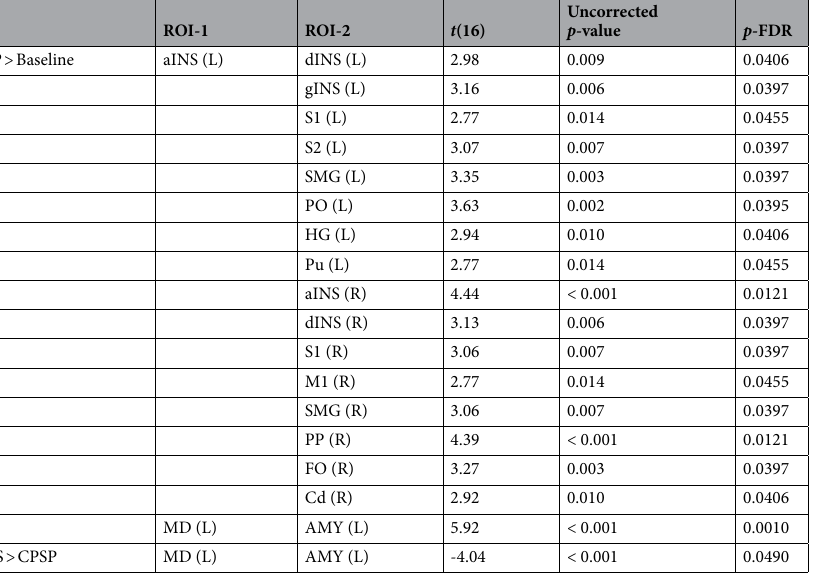
Table 1. The statistical values in ROI-to-ROI analysis. The p -values and t -values of the functional connectivity that significantly changed in the ROI-to-ROI analysis. The significance level was the ROI-level adjusted for multiplicity ( p -FDR < 0.05). aINS agranular insular cortex, AMY amygdala, Cd caudate, CPSP central poststroke pain, dINS dysgranular insular cortex, FDR false discovery rate, FO frontal operculum,